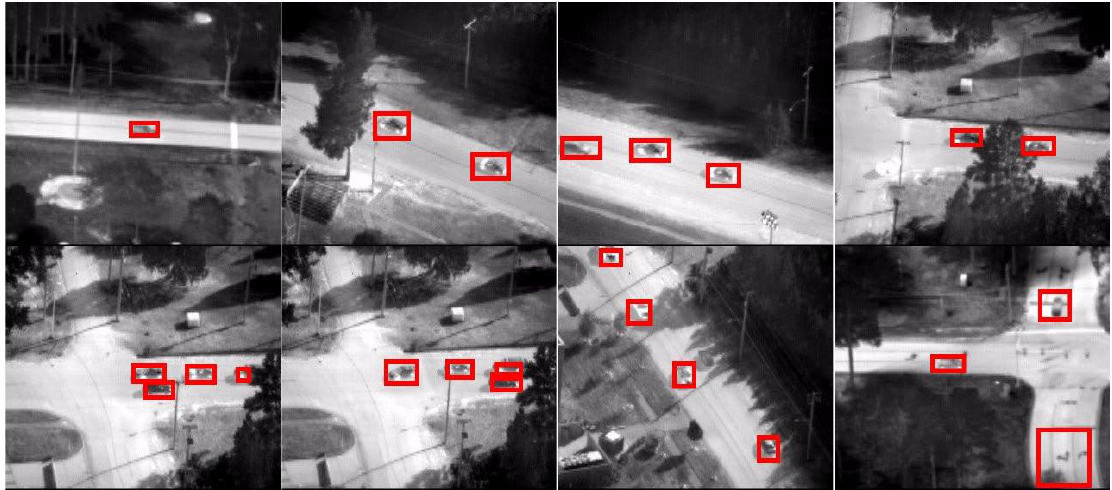
Figure 6. The performances of the method on part of the images of VIVID_pktest1